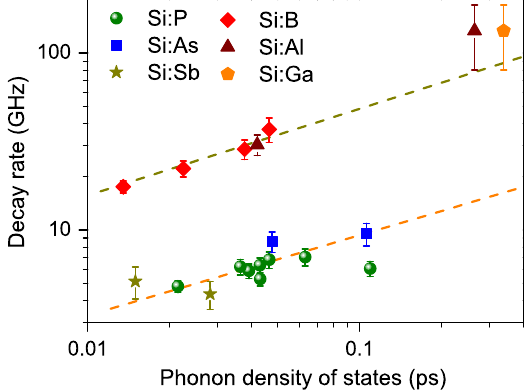
FIG. 8. Universal relationship between population decay and one-phonon density of states. The phonon DOS is from Fig. 7(d) and given in units of inverse frequency [27]. The decay rates, 1 =T 1 , at 5 K are shown for the acceptors from Fig. 7, along with donors—phosphorus and arsenic from Ref [15] and antimony from Fig. 5. Two acceptor transitions are near the TO phonon band and have very fast decays at the limit of our resolution. The lines shown are guides to the eye with slope of 1 (i.e., propor- tional